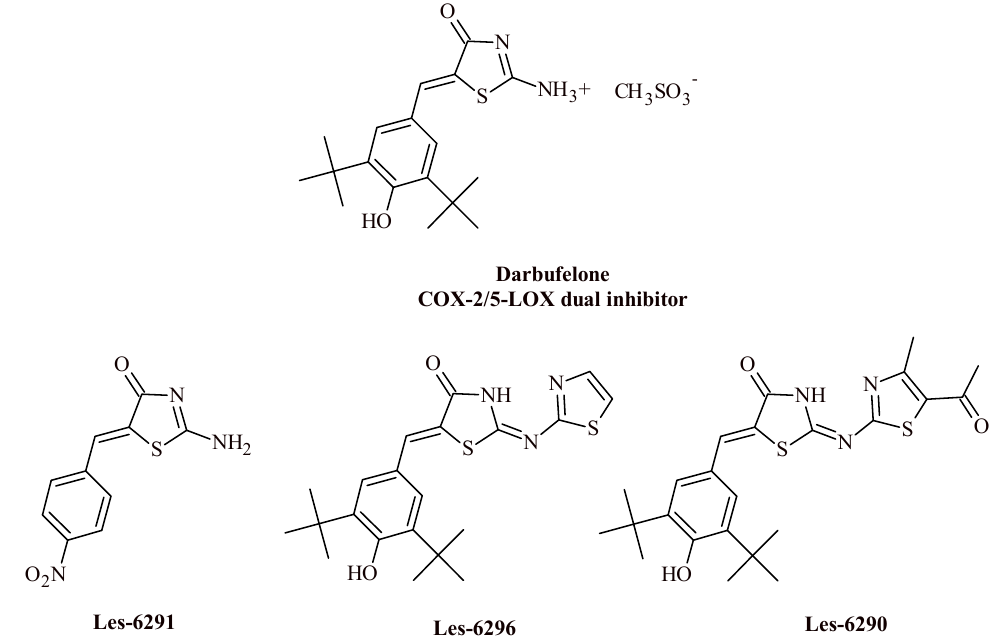
Figure 31. Darbufelone and its analogues with anticonvulsant activity.